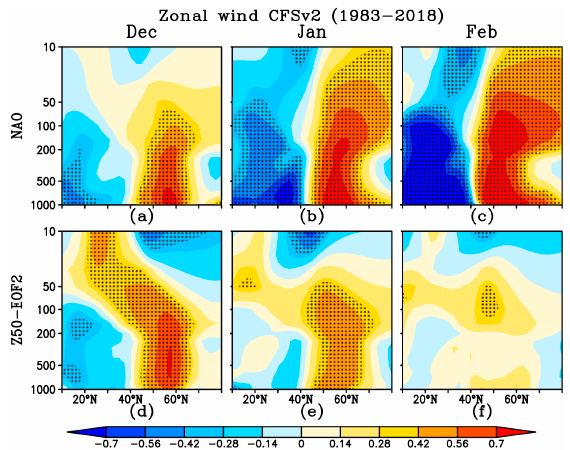
Figure 10. TCCs between the NAO and zonal mean zonal wind ( a – c ), and TCCs between the principal component (PC) of Z50-EOF2 and zonal-mean zonal wind predicted by CFSv2 ( d – f ) in December ( a , d ), January ( b , e ), and February ( c , f ) at one month lead time during the period 1983–2018. Dotted areas indicate statistical significance at the 95% confidence level, as estimated by a local Student’s t- test.